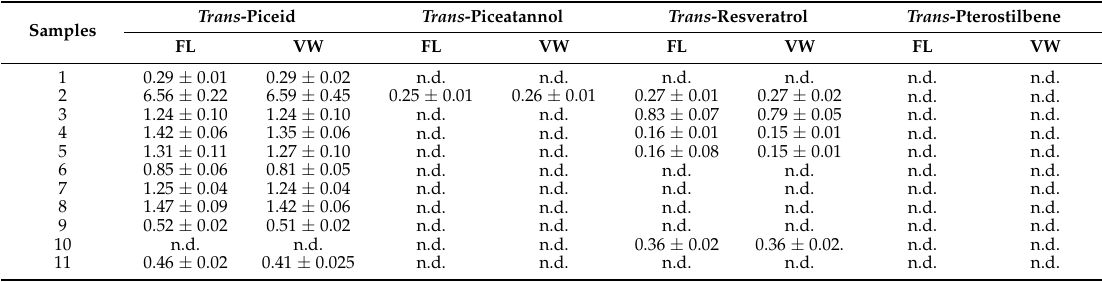
Table 2. Concentrations of trans -stilbenes ( µ g/mL) with fluorescence detector (FLD) and variable wavelength (VW) detectors in commercial grape juices, n = 3 replicates.